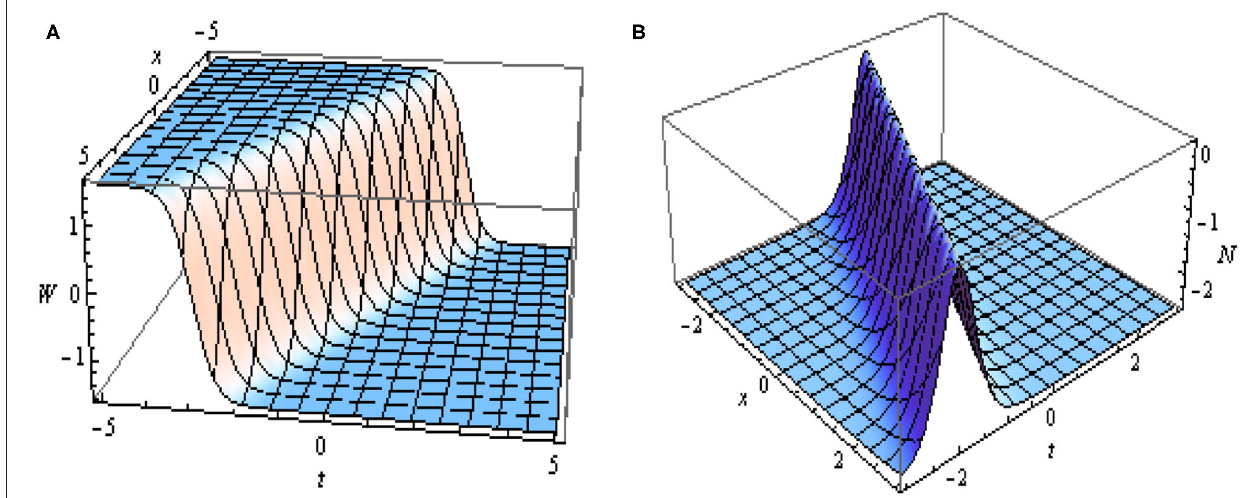
W ( x , t ) N ( x , t ) and given in Equations (11) and (12) with suitable choose of values of parameters as l | | | |